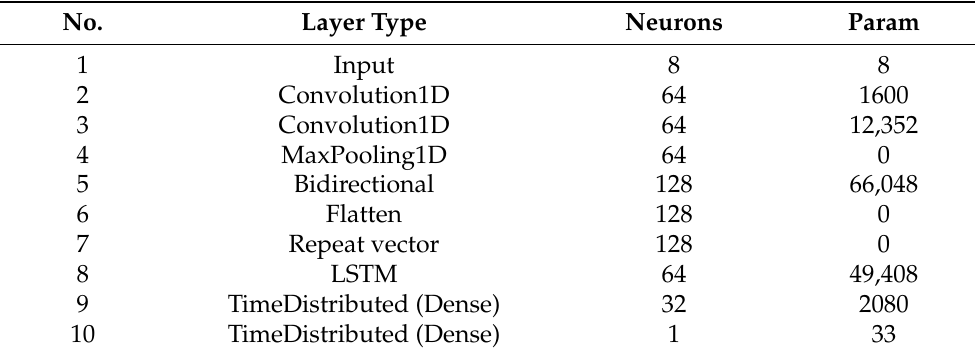
Table 3. The proposed CBLSTM-AE and its